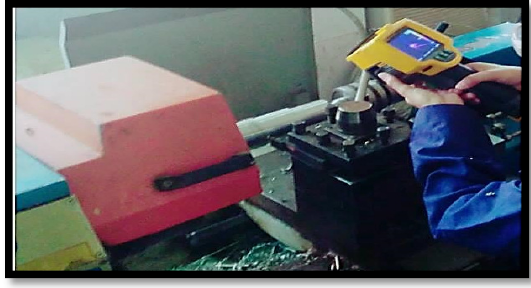
6. Workpiece on the machine and temperature measurement using fluke camera.